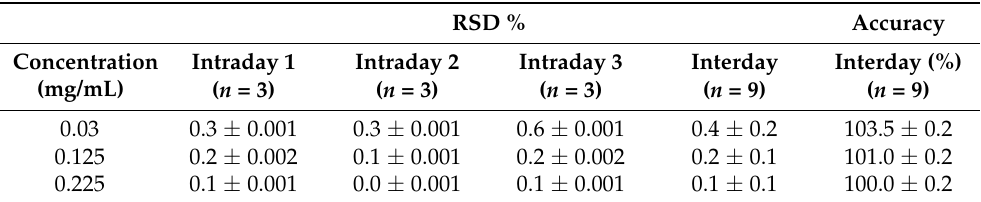
Table 2. Precision (RSD%) and accuracy (%) of essential oil samples of Z. rhoifolium fruits used in the validation of the analytical method.